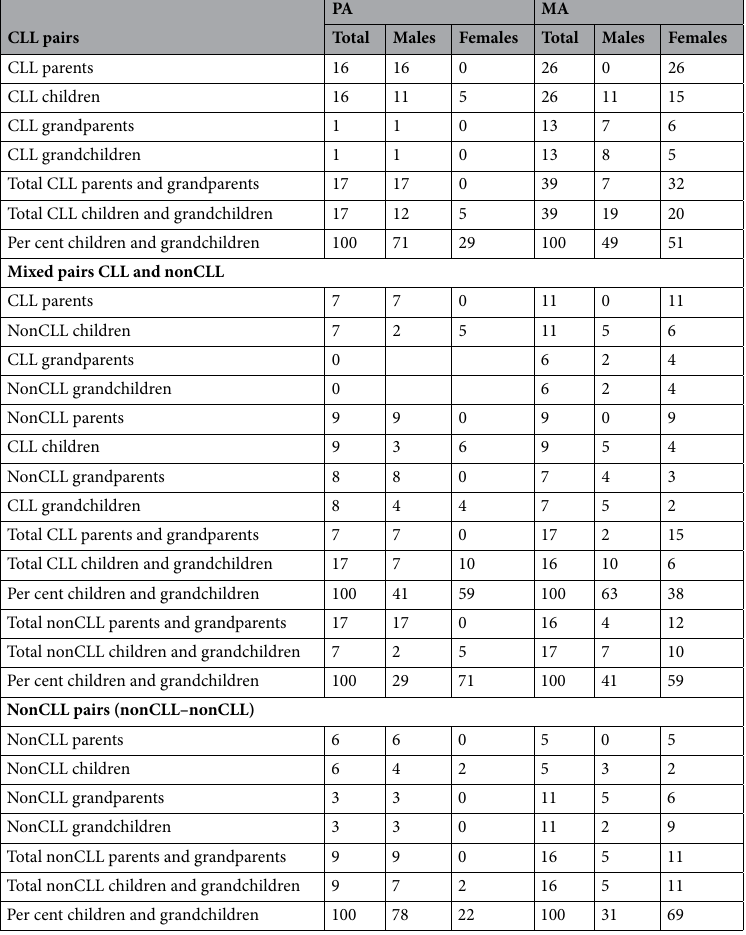
population was under the influence of isolation and consanguinity right up to a period after WW II 40 . Foreign